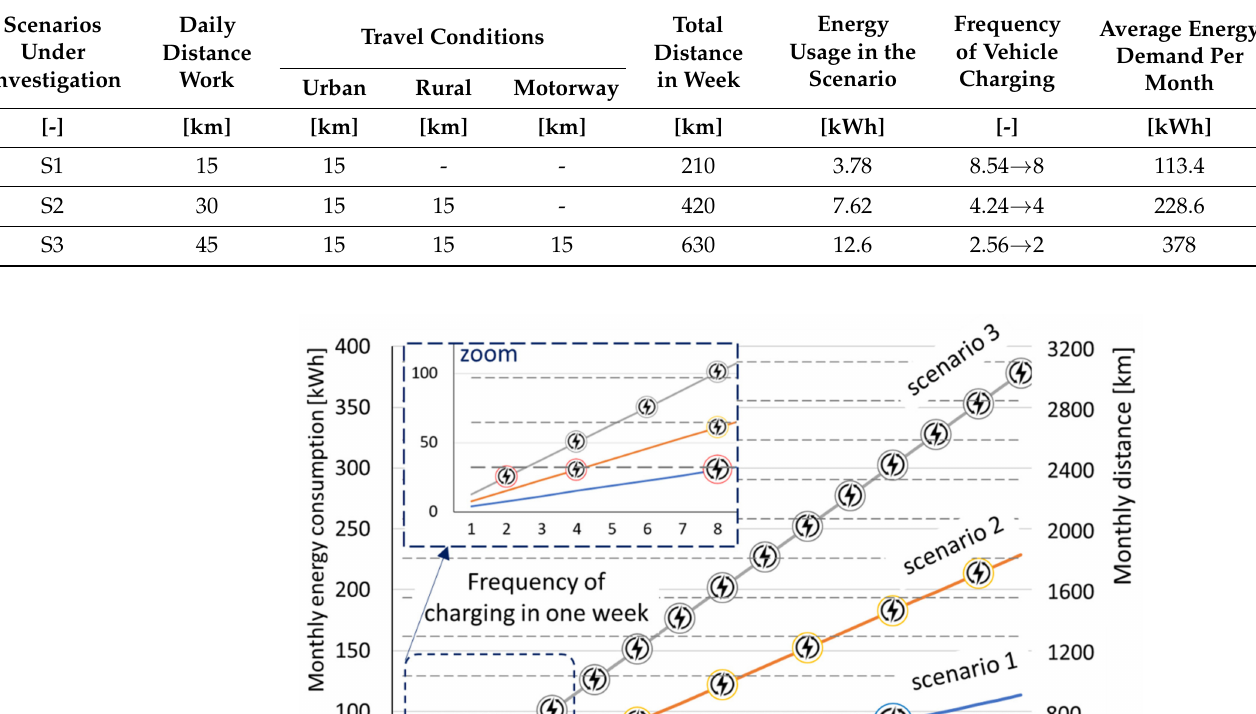
Table 8. Analyzed scenarios of distances covered by an electric vehicle.